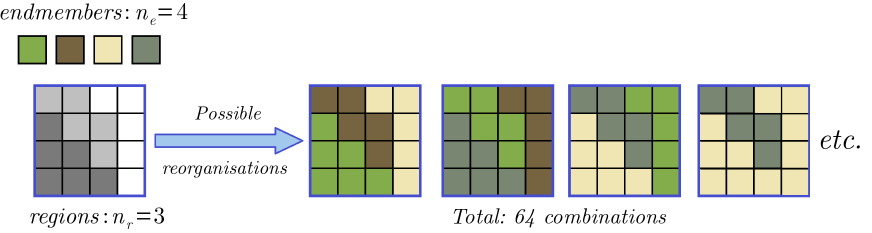
Figure 3. Principle of the spatial-reorganisation step performed by a combinatorial